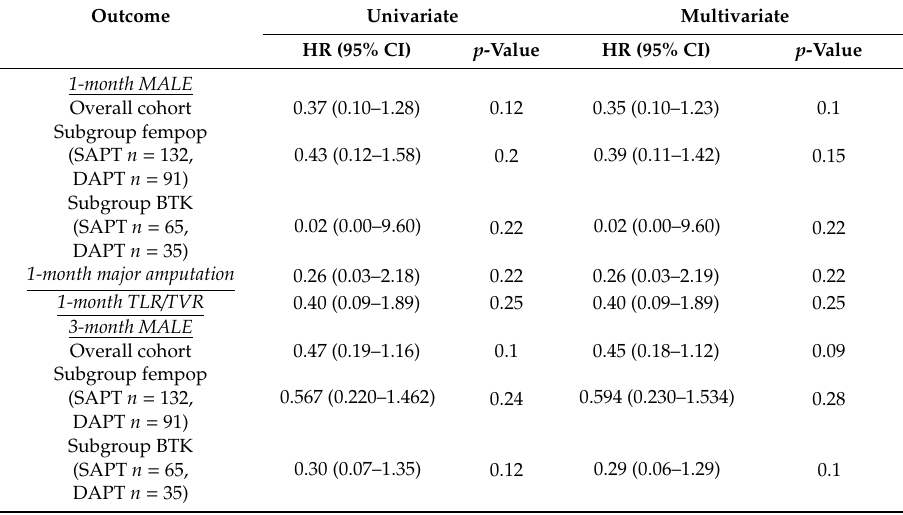
Table 4. MALE outcomes at 1, 3, and 12 months between SAPT ( n = 159) and DAPT ( n = 99). Outcome Univariate